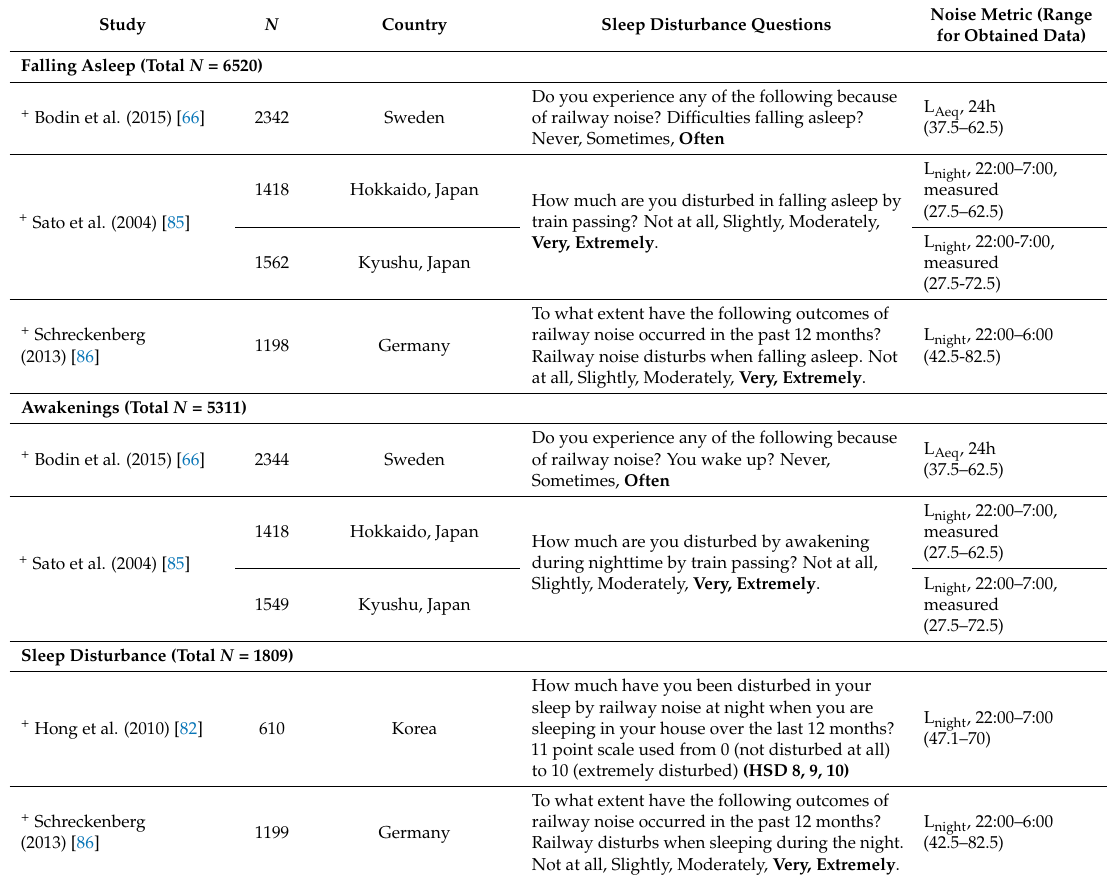
Table 4. Studies on railway noise and self-reported sleep disturbance (* general health survey, + noise survey). Studies modeled the noise levels except where indicated. Response alternatives contributing to calculation of the percent Highly Sleep Disturbed are in